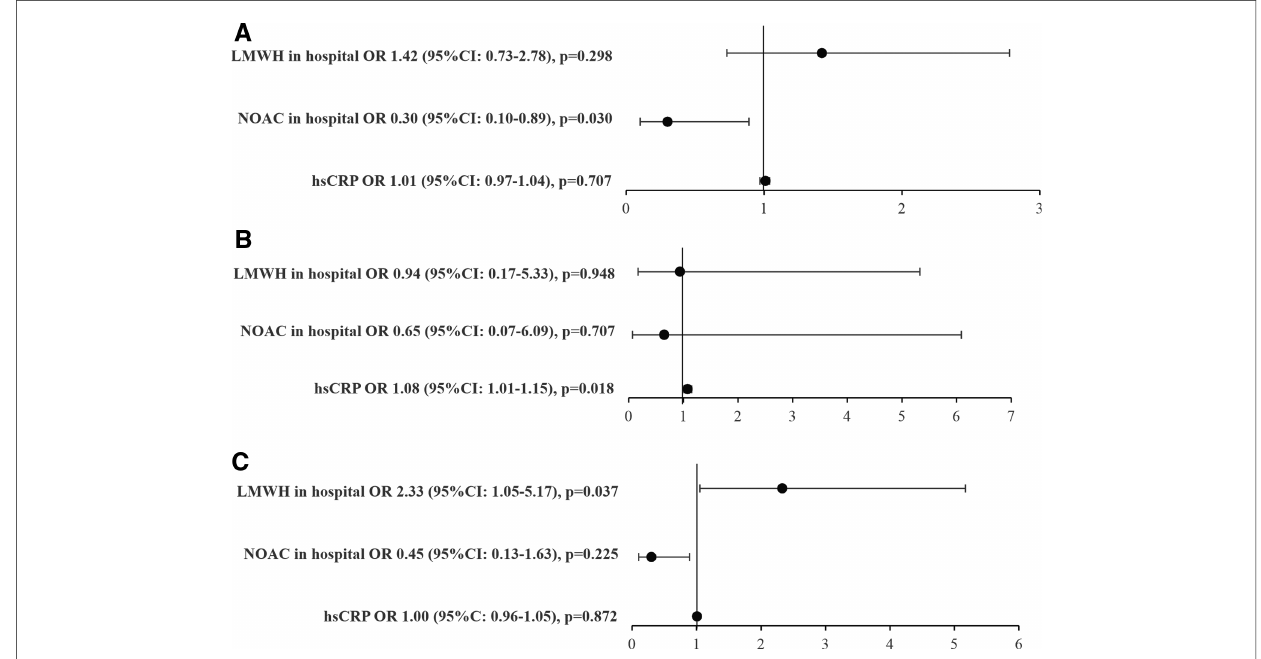
FIGURE 3 Multivariable logistic regression, n =421*. Predictors of: ( A ). MACE α , ( B ). Pulmonary embolism, ( C ). RBCs transfusions β . α - MACE, major adverse cardiovascular events including any incident stroke, myocardial infarction or acute peripheral artery ischemia; β - need for red blood cells (RBCs) transfusion as a surrogate for major bleeding events; * - patients with requirement for mechanical ventilation, renal replacement therapy or those who were treated during hospital stay by two different anticoagulants or were switched within any anticoagulant agent to another (VKA vs. NOACs vs. LMWH) were excluded; abbreviations: CI, con fi dence interval; hsCRP, high-sensitivity C reactive protein (increase per 10 mg/L); LMWH, low molecular weight heparin; NOAC, novel oral anticoagulants; OR, odds ratio; RBCs, packed red blood